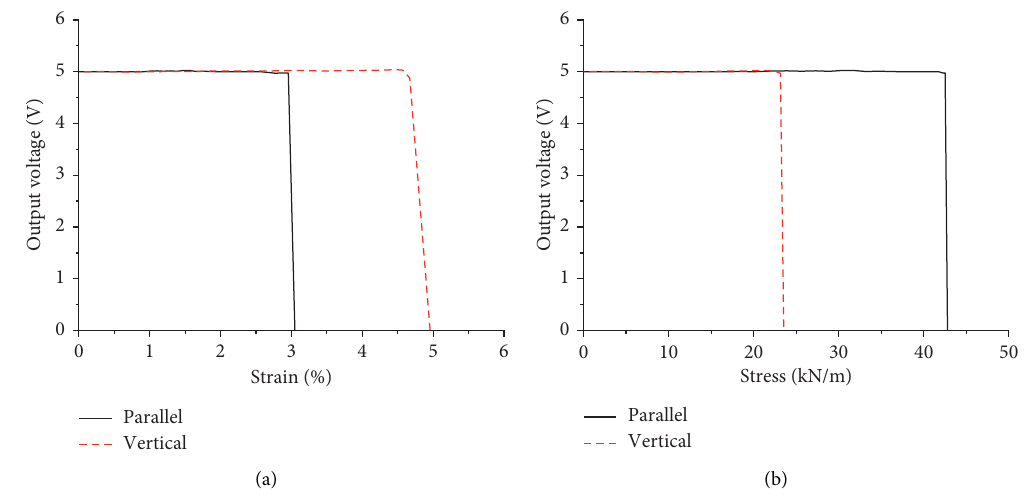
Figure 8: Output voltage curve of solar cells. (a) Output voltage-strain. (b) Output voltage-stress.